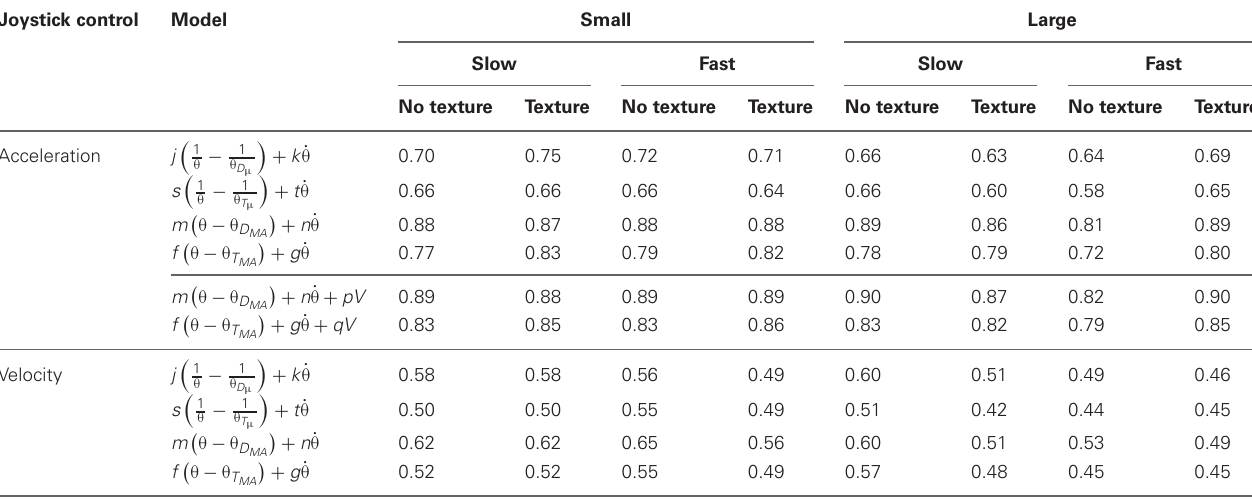
Also included are the R 2 values obtained when own-velocity (V) was added as an additional parameter to the moving average models for the acceleration-control conditions only (see text for